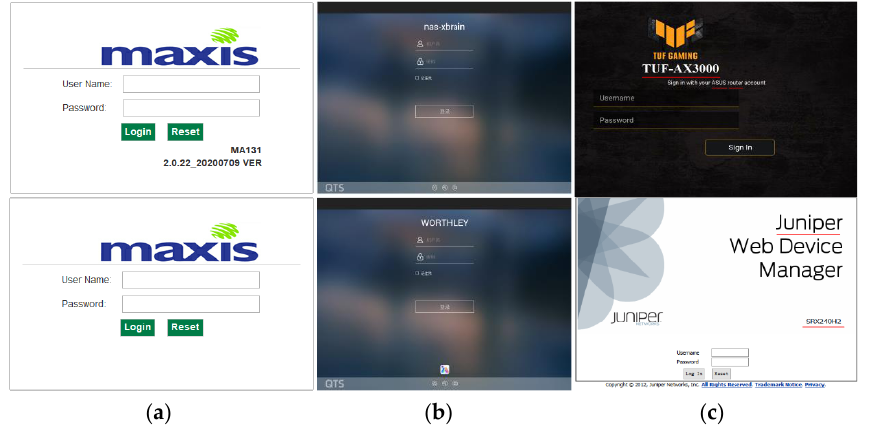
Figure 1. Samples of device login page screenshot: ( a ) maxis; ( b ) QNAP; ( c ) ASUS and Juniper.